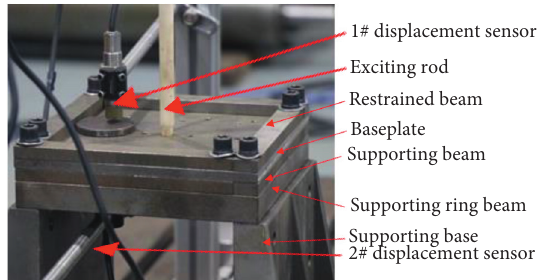
Figure 9: Displacement deviation test